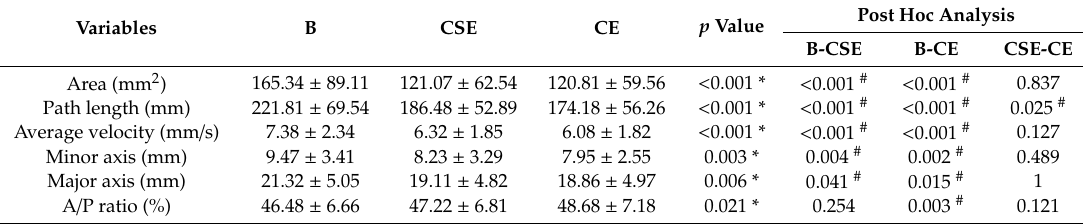
Table 3. Comparison of static balance ability in the eye-closed condition.